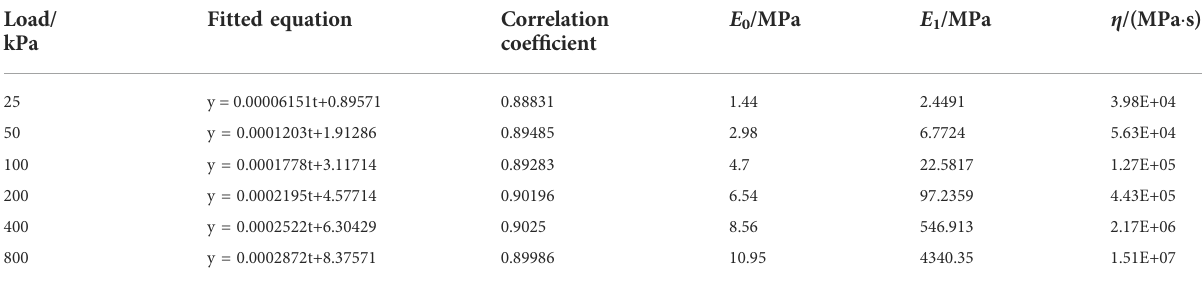
TABLE 3 Rheological model fi tting results and parameters of the samples when the ratio of bio-enzyme was 0.01%. Load/ kPa